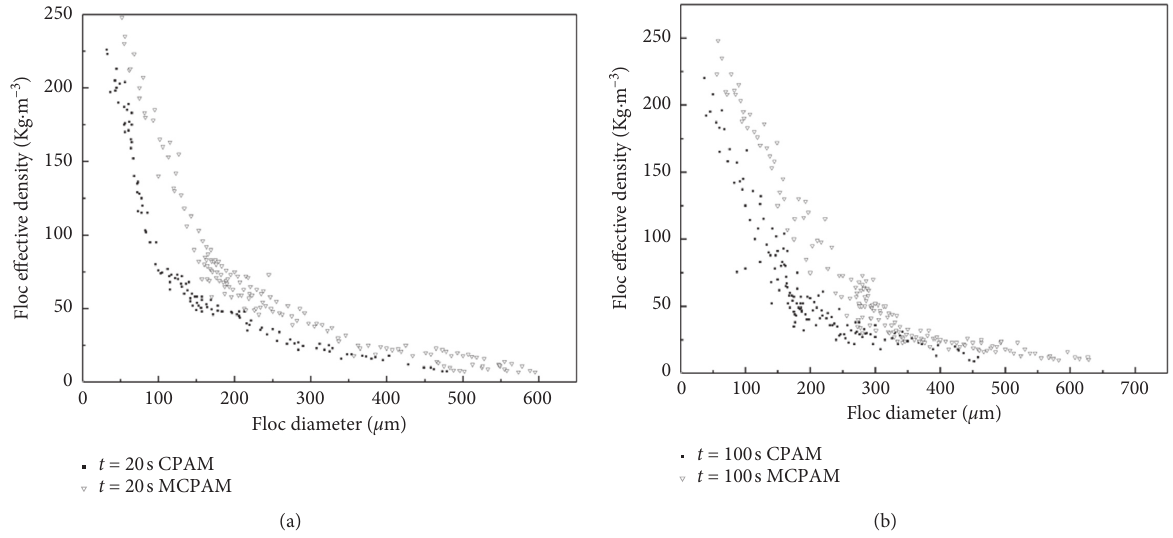
Figure 4: Relationship between floc diameter and effective density at (a)20 seconds and (b)100 seconds in the MCPAM and CPAM flocculations.